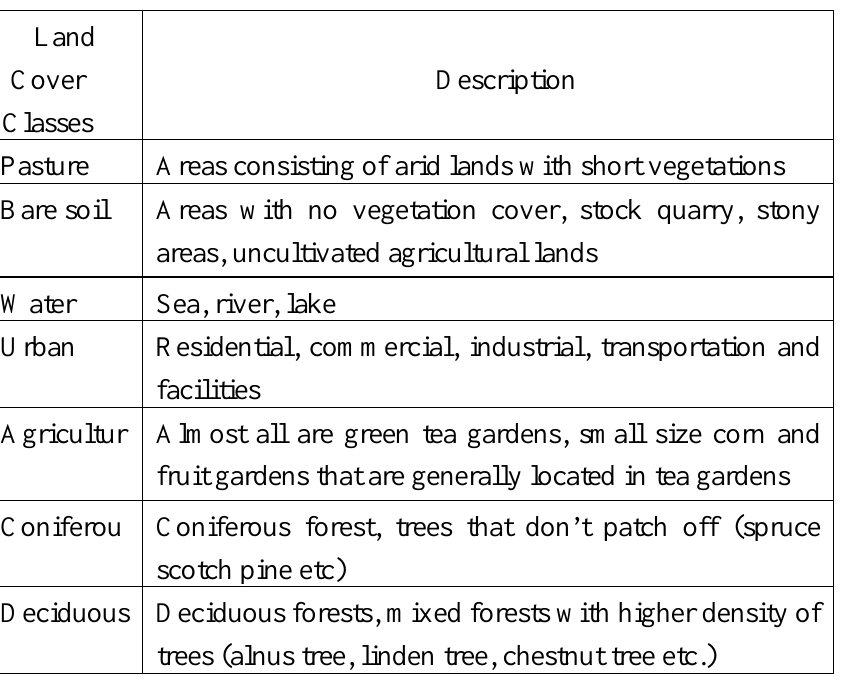
Table 1. Land cover classification